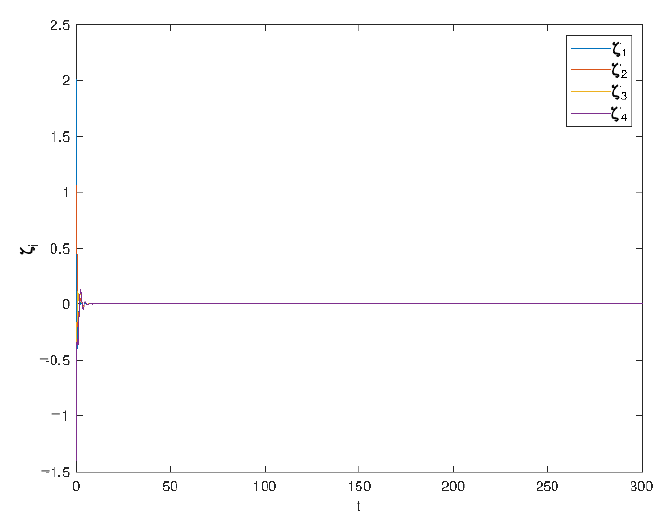
Figure 3. The adaptive gains κ i , i = 1, . . . ,4.